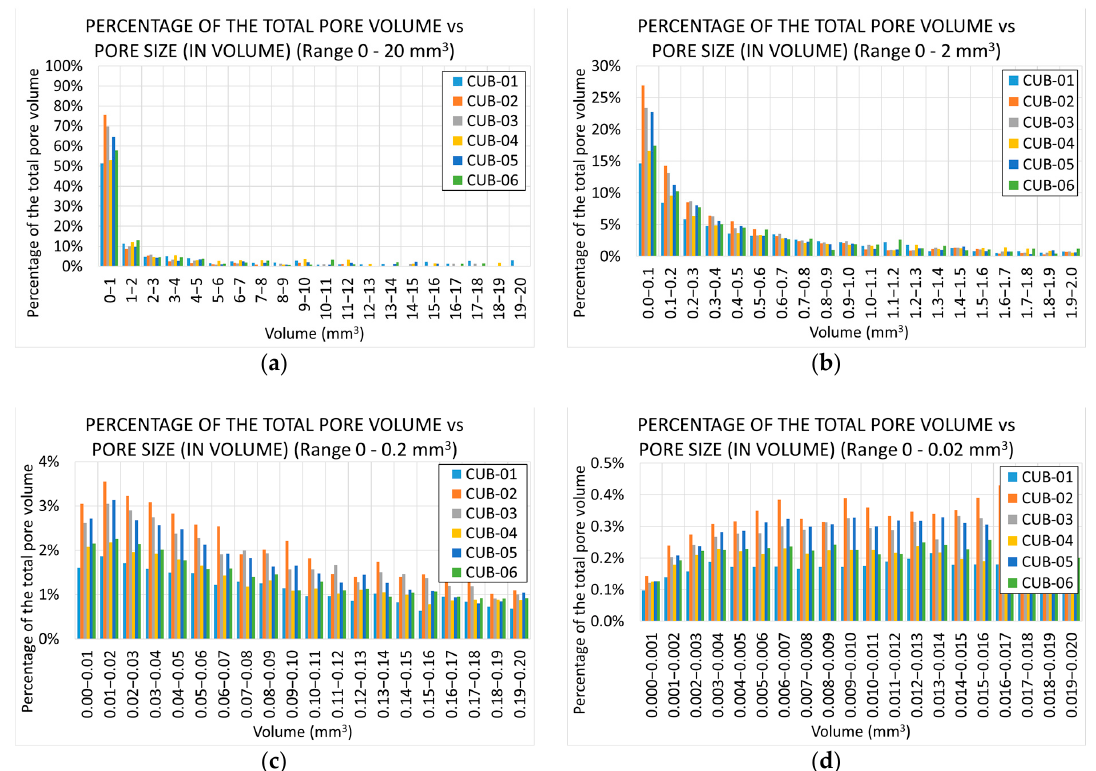
Figure 20. Histograms of pore-volume distribution (in volume) for different ranges, from the largest to the smallest ( a – d ).